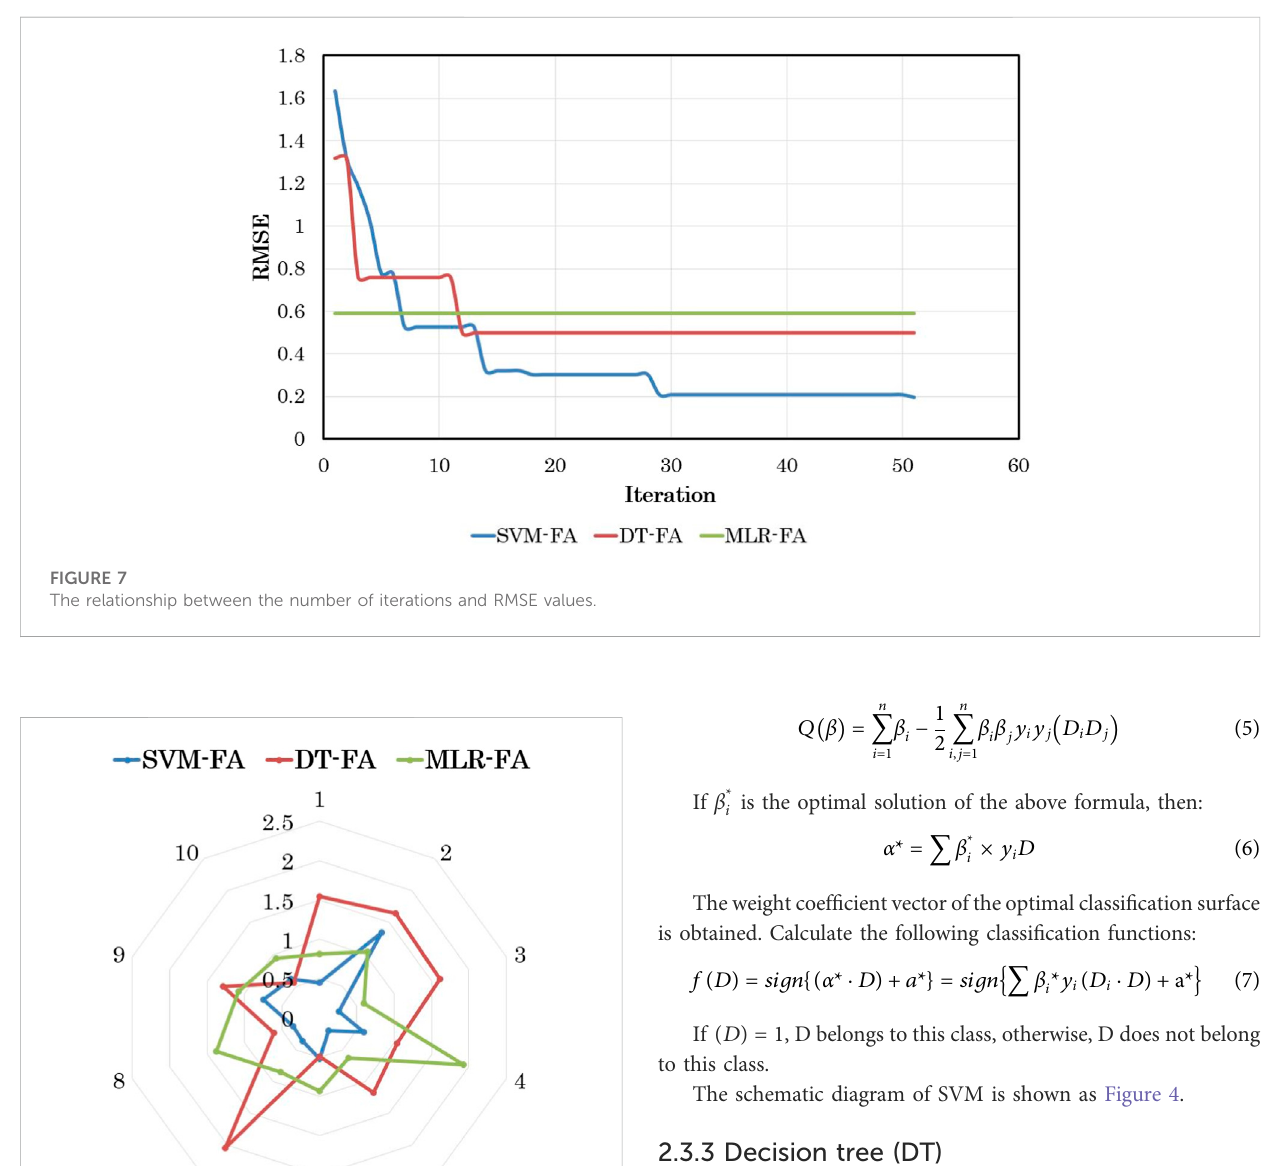
FIGURE 8 RMSE values of different